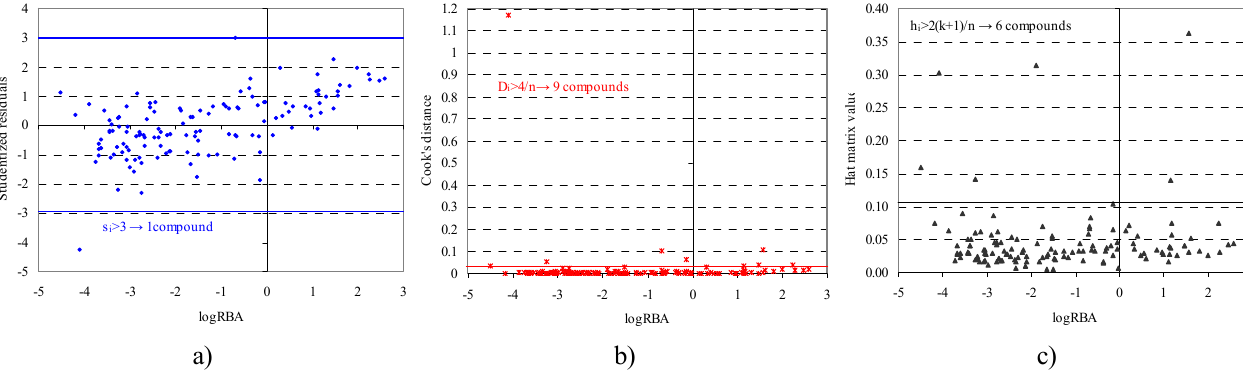
Fig. 1. Studentized residuals (a), Cook’s distance (b) and hat matrix values (c) versus logRBA in model with all compounds in training set (n=132) MLR IN T RAINING S ETS : M ODELS C HARACTERISTICS